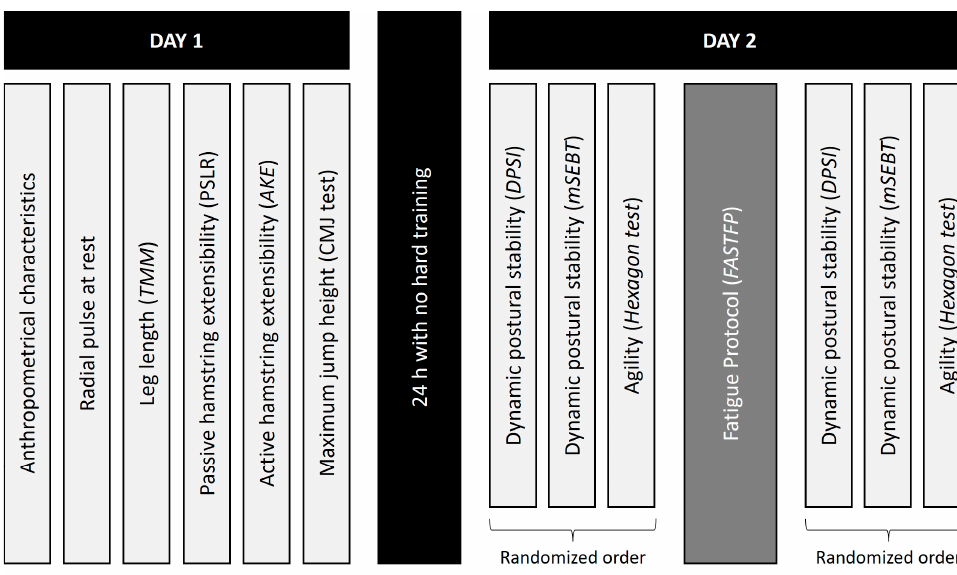
Figure 1. Assessment protocol used in this study.